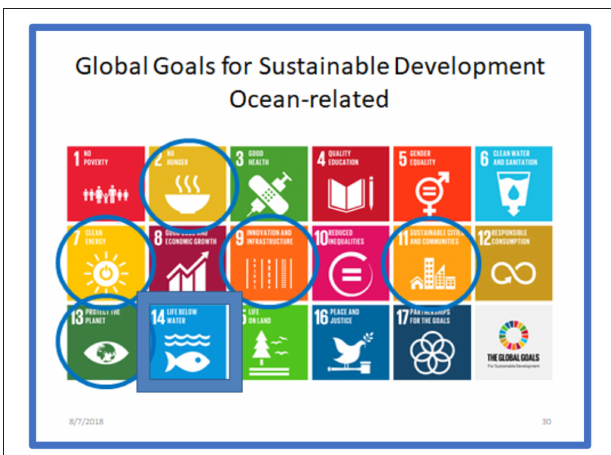
FIGURE 1 | The 17 sustainable development goals identified by the United Nations to build toward a better and more sustainable future and address the global challenges faced by society. (UN, 2018a) 1